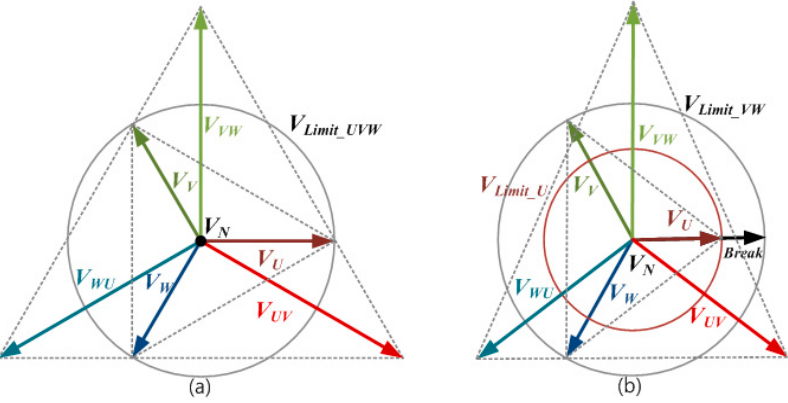
Figure 3. ( a ) Normal operation, ( b ) phase voltage and line-to-line voltage vector diagram of bypass operation when one failure occurs in the U